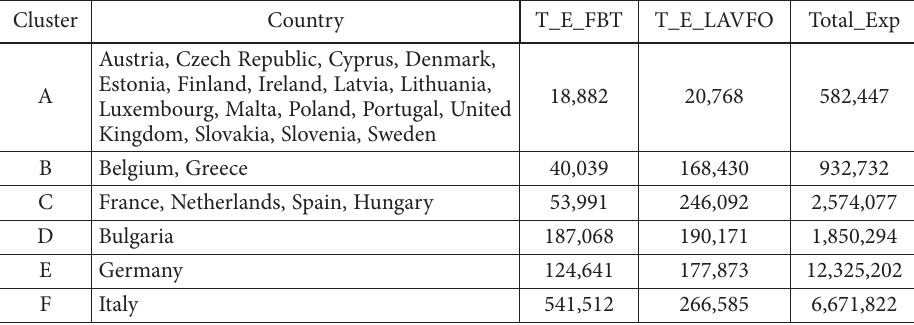
Table 9. EU states grouping according to the average volume at group level of Romania’s exports (FOB) in 2016 (thousands euro) (source: authors’ computations based on NIS, 2018) Cluster Country T_E_FBT T_E_LAVFO